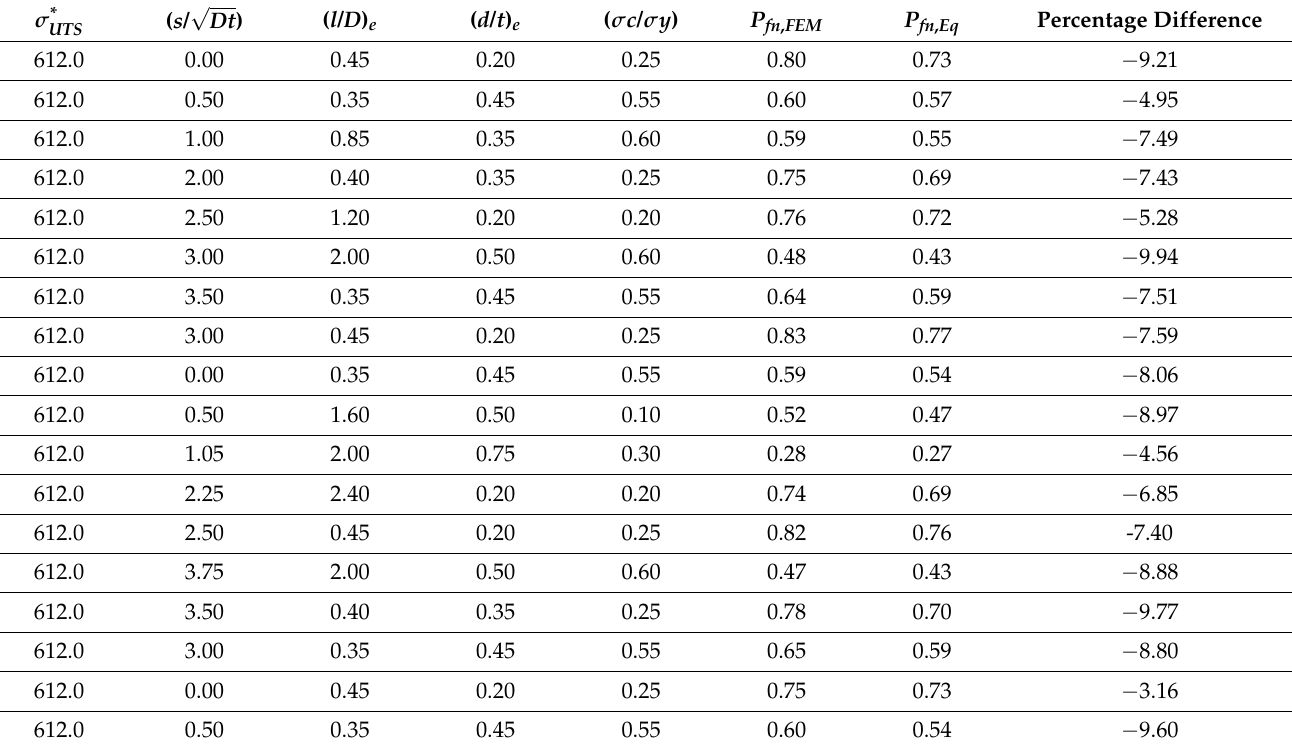
Table 10. Comparison of the failure pressure obtained using FEA and the empirical equation for arbitrary